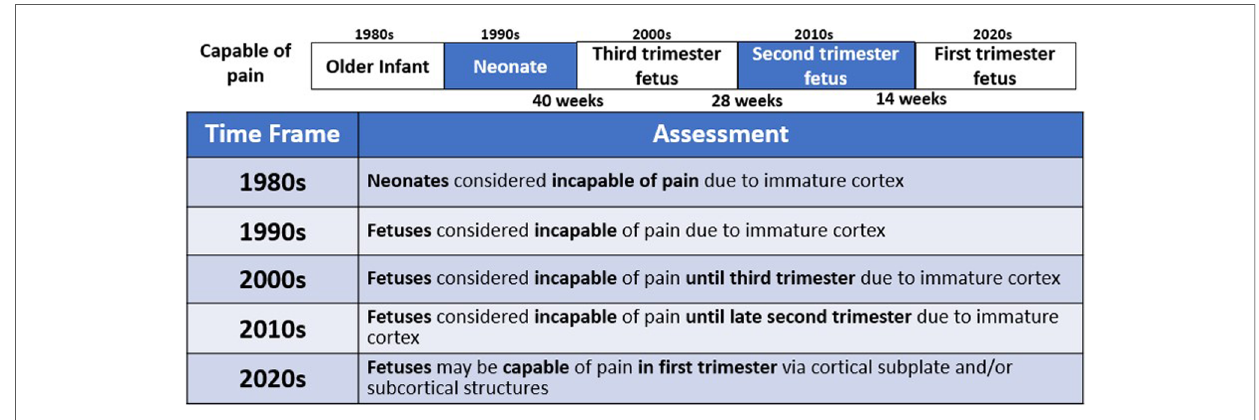
FIGURE 3 An evolving understanding of pain. Scienti fi c understanding and recognition of pain capacity in the neonate and fetus have evolved over time. In the 1980s and 1990s, medical consensus held that neonates (32, 38) and fetuses (15) lacked the capacity to perceive pain. In the 200s (12), 2010s (34), and 2020s (4, 35, 36), the understanding of fetal pain capacity has